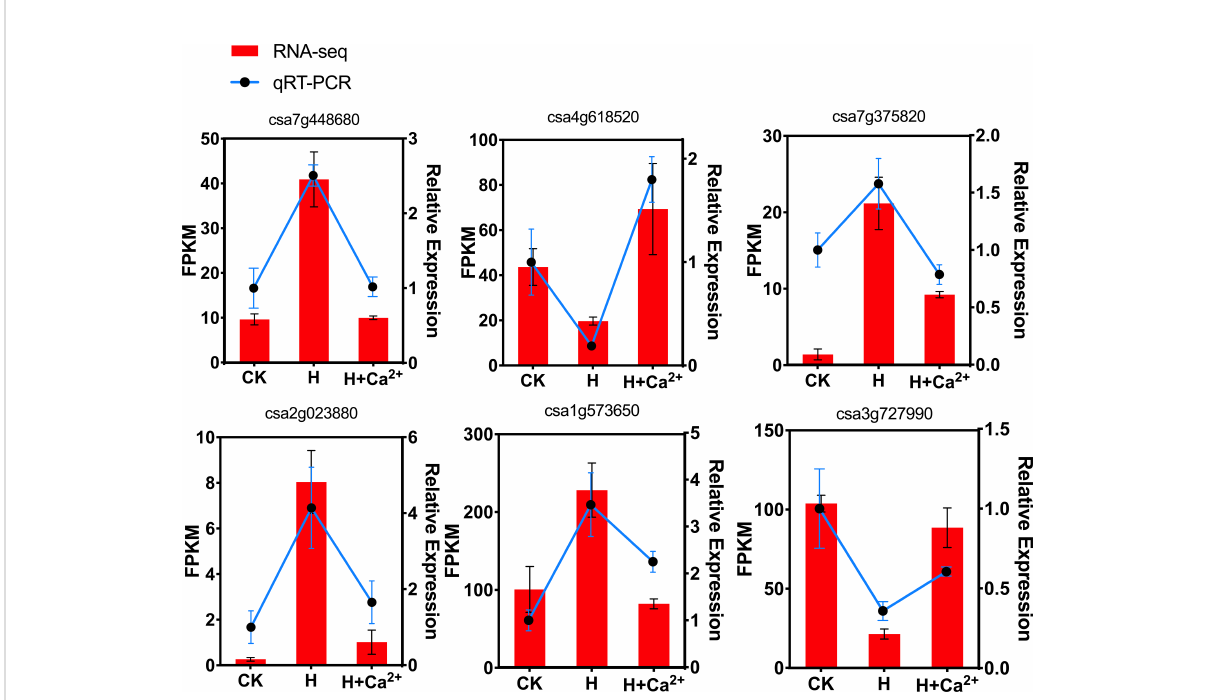
FIGURE 8 Validation of RNA-seq data by qRT-PCR. The y-axis on the left indicates the differential expression of the gene for RNA-seq, and the y-axis on the right indicates the differential expression of the gene for qRT-PCR. cDNA analysis was performed by quantitative reverse